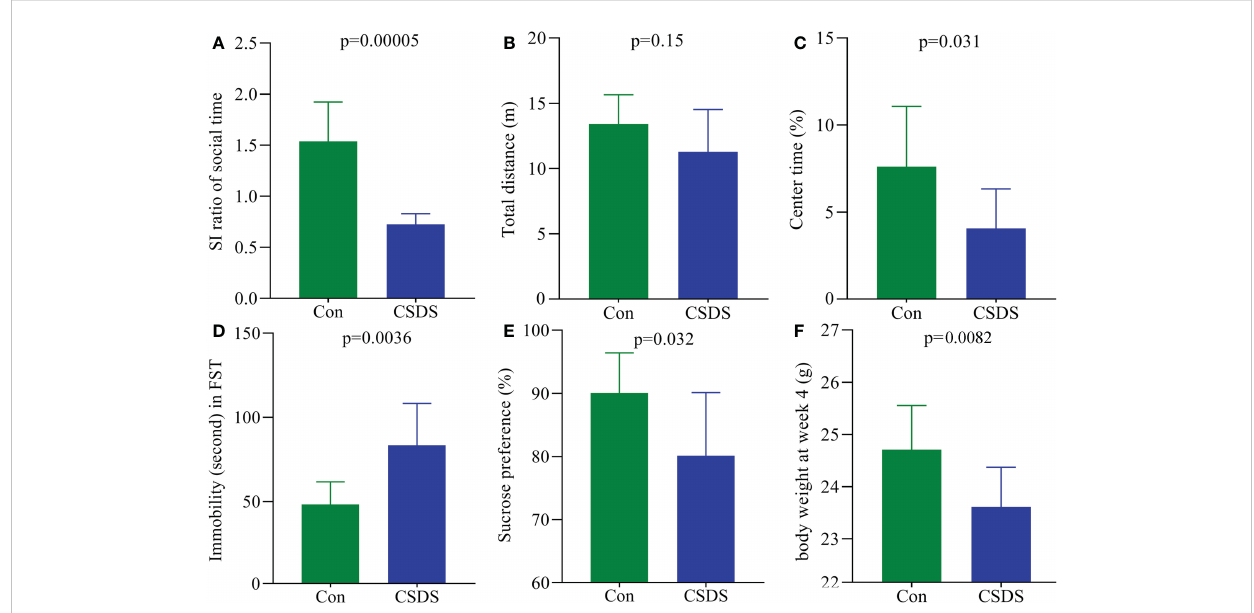
FIGURE 1 Depressive-like behaviors in CSDS-induced depressed mice. (A) CSDS mice had the signi fi cantly lower SI ratio compared to control mice; (B, C) in open fi eld test, CSDS mice had the similar total distance (B) and signi fi cantly lower center time (%) (C) compared to control mice; (D) the immobility time was signi fi cantly higher in CSDS mice than in control mice; (E, F) after CSDS procedure, both sucrose preference (%) (E) and body weight (F) were signi fi cantly lower in CSDS mice than in control mice. SI, social interaction; Con, control; CSDS, chronic social defeat stress; FST, force swimming